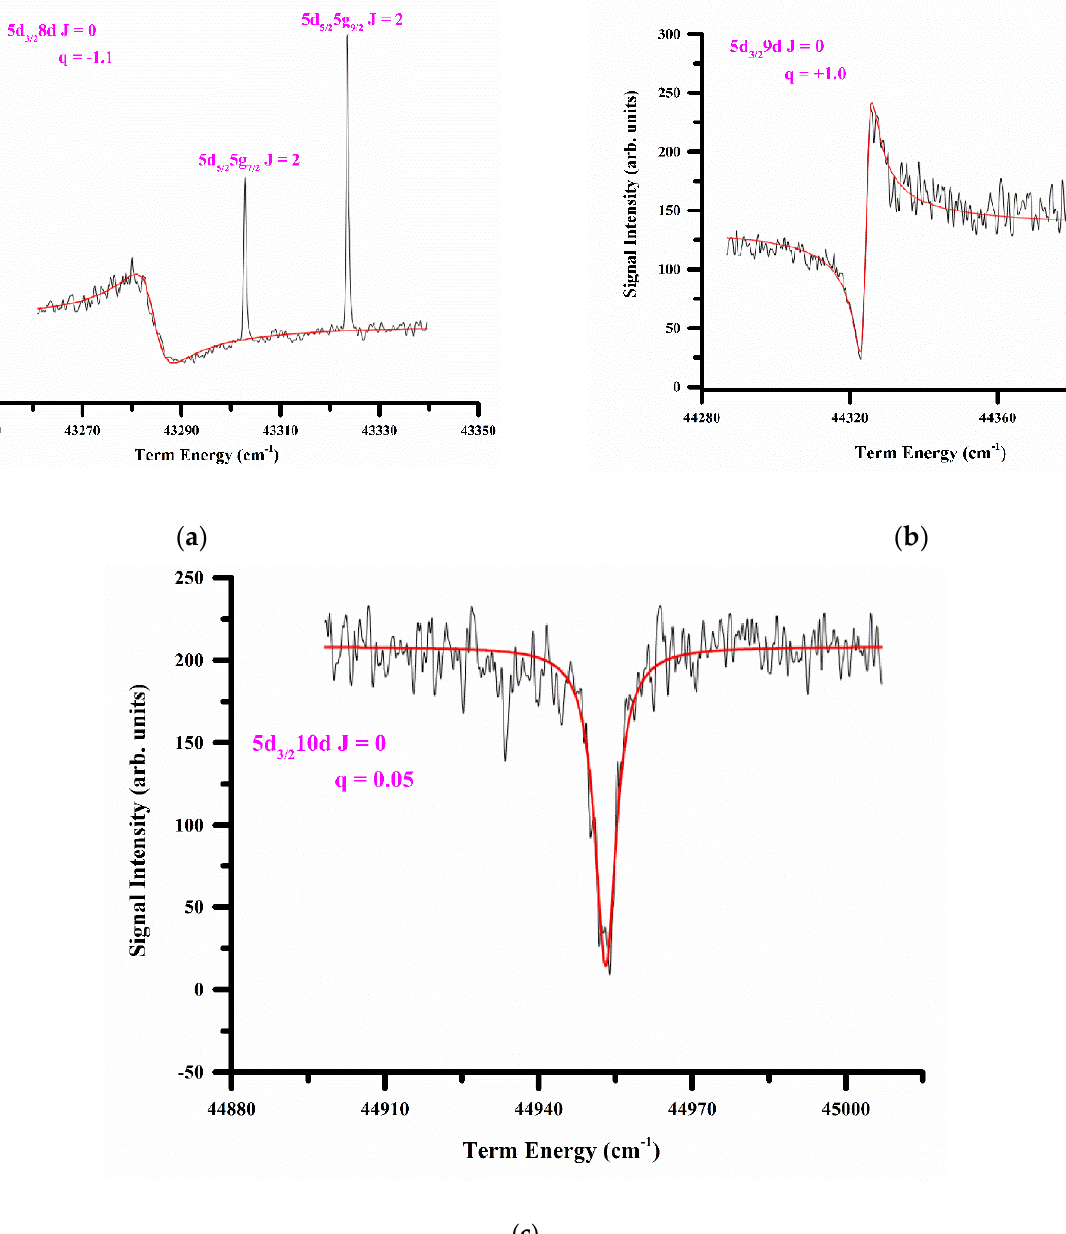
Figure 10. ( a , b , c ). Line profiles of the 5d 3/2 8d (J = 0) and 5d 3/2 9d (J = 0) autoionizing resonances in barium show different signs of q-parameter as the principal quantum number is increased by one unit. ( c ). Line profile of the 5d 3/2 10d (J = 0) autoionizing resonance along with the fit of Fano relation for an isolated autoionizing resonance.